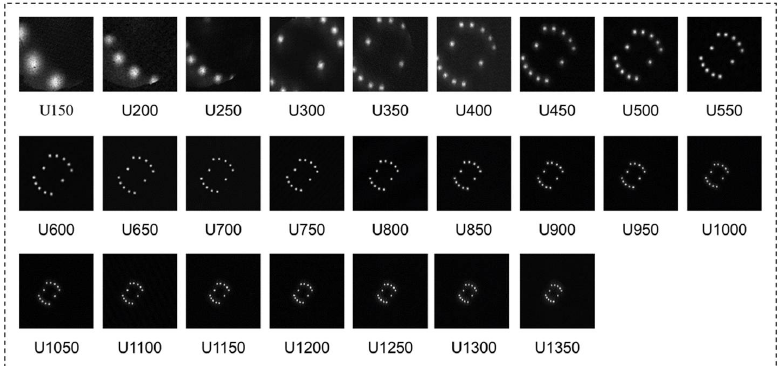
Figure 11. The reconstruction images of the lamp at different depths using the single-pixel imaging method with the single-pixel detector whose radius is 10 pixels.